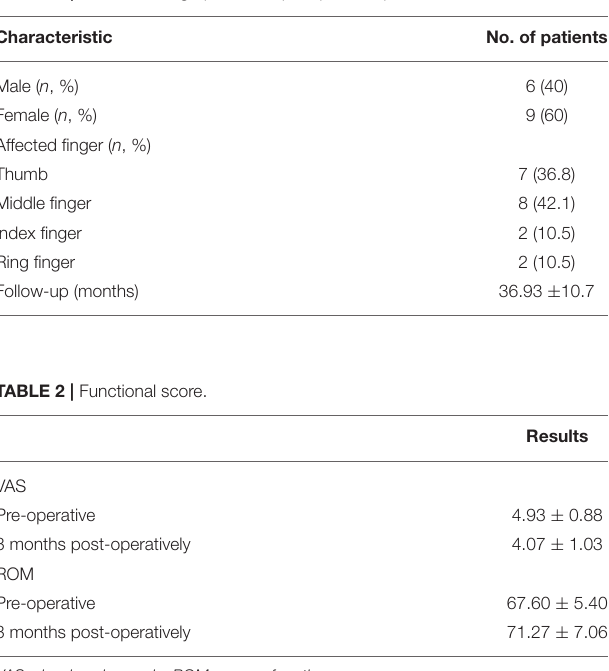
TABLE 1 | Patient demographics and perioperative parameters.